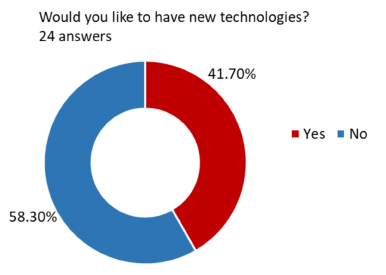
Figure 22. Participants’ interest in applying new